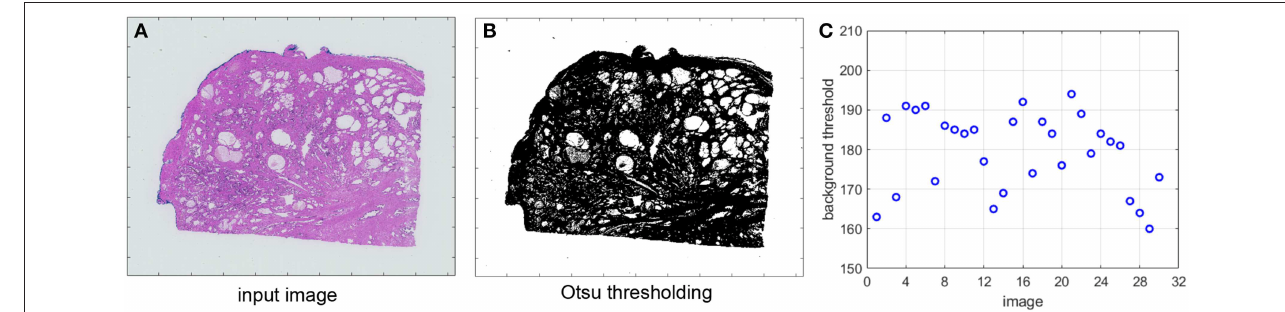
FIGURE 5 | (A) Original image. (B) Otsu thresholding. (C) Otsu-detected thresholds for a set of